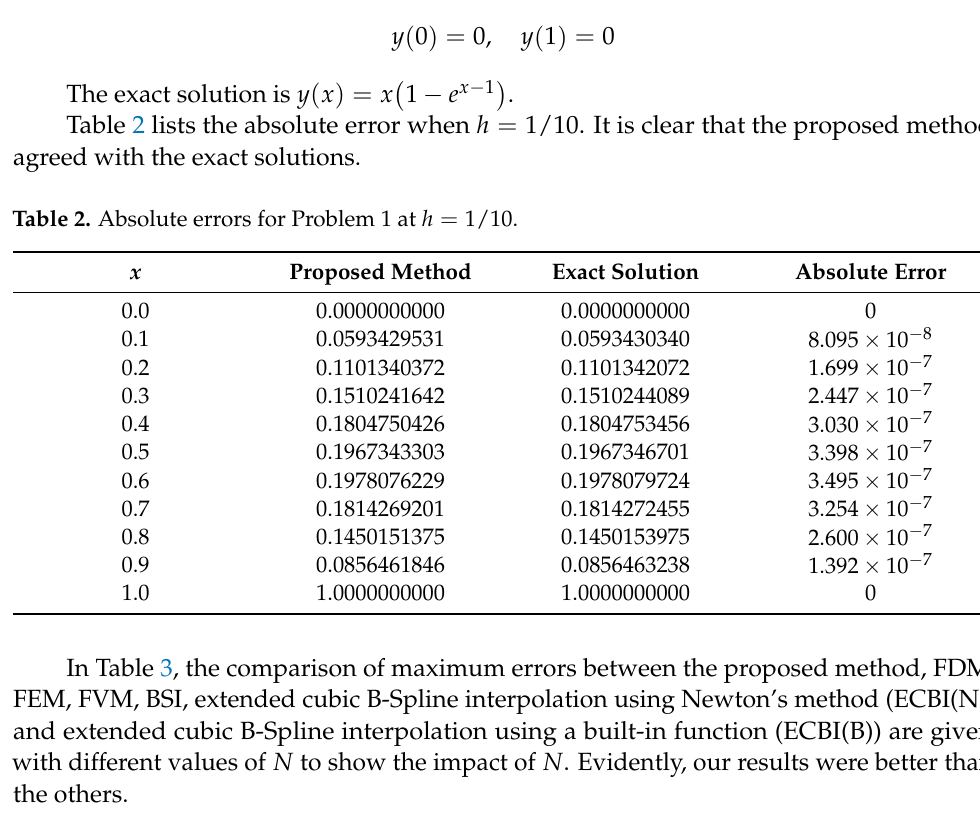
Table 3. Comparison of maximum errors for Problem